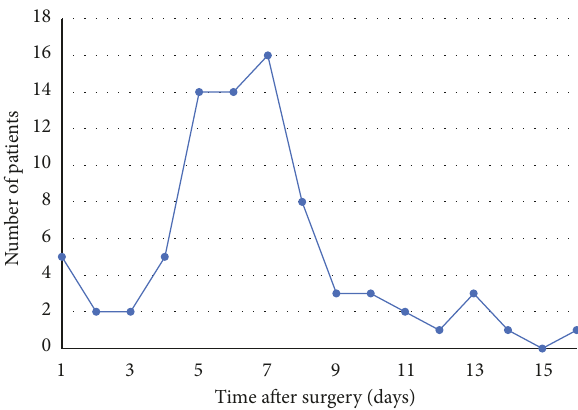
Figure 1: Incidence of posttonsillectomy haemorrhage according to time after